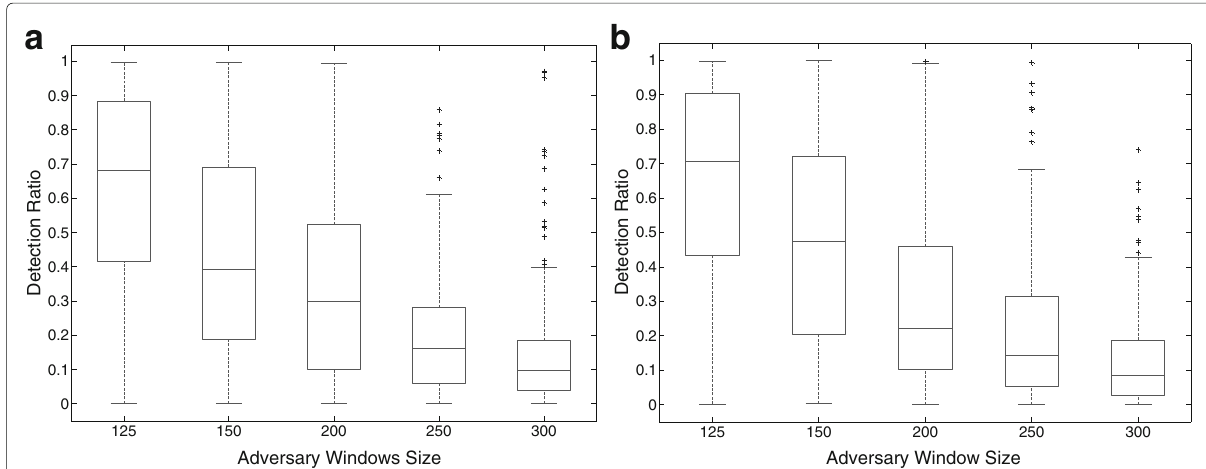
Fig. 12 Numeric simulation results using the single- and multi-watermark detection schemes with the same performance loss, and different adversary window size for eavesdropping the data channel before the attack. The order used by the adversary is the correct system order, p = 25 a Detection ratio for the single-watermark approach. b Detection ratio for the multi-watermark approach. a Detection ratio function with respect to the single-watermark against a parametric cyber-physical adversary using different adversary window sizes for eavesdropping the data of the channel before the attack. b Detection ratio function with respect to the multi-watermark against a parametric cyber-physical adversary using different adversary window sizes for eavesdropping the data of the channel before the